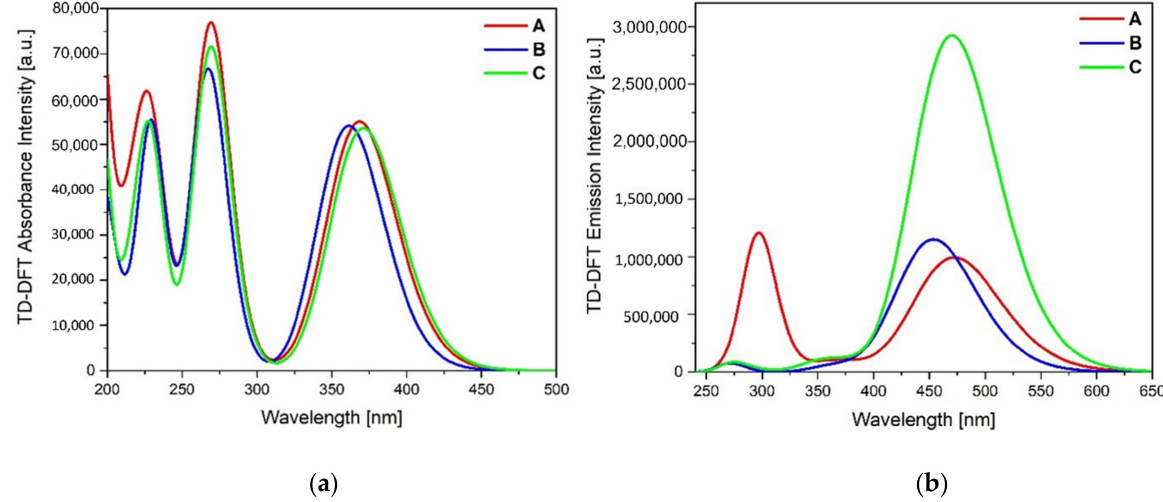
Figure 6. TD-DFT (CAM-B3LYP/6-31G(d,p)) calculated absorption ( a ) and emission ( b ) spectra for molecules A – C